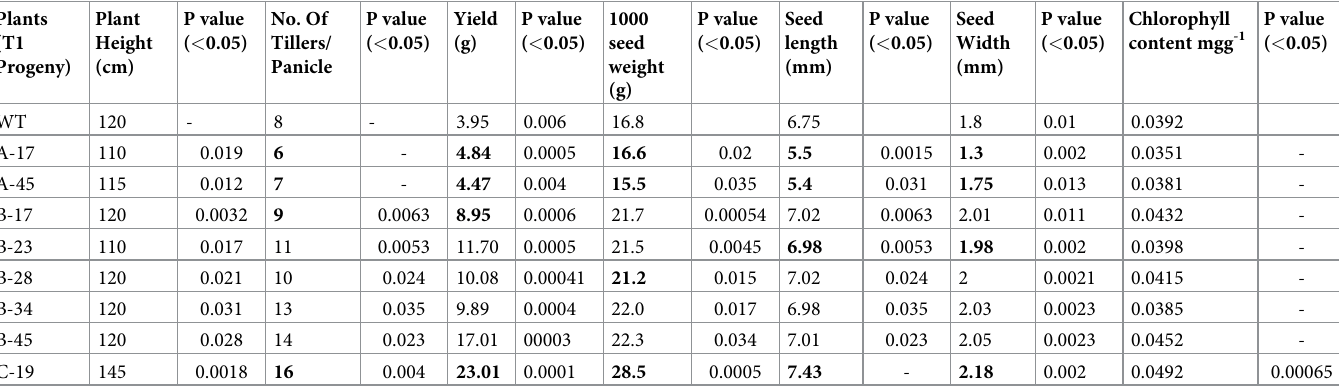
Table 3. Morphological characterization of T1 transgenic progeny plants with statistical analysis (student’s t-test). Plants Plant P value No. Of (T1 Height ( < 0.05) Progeny) (cm)